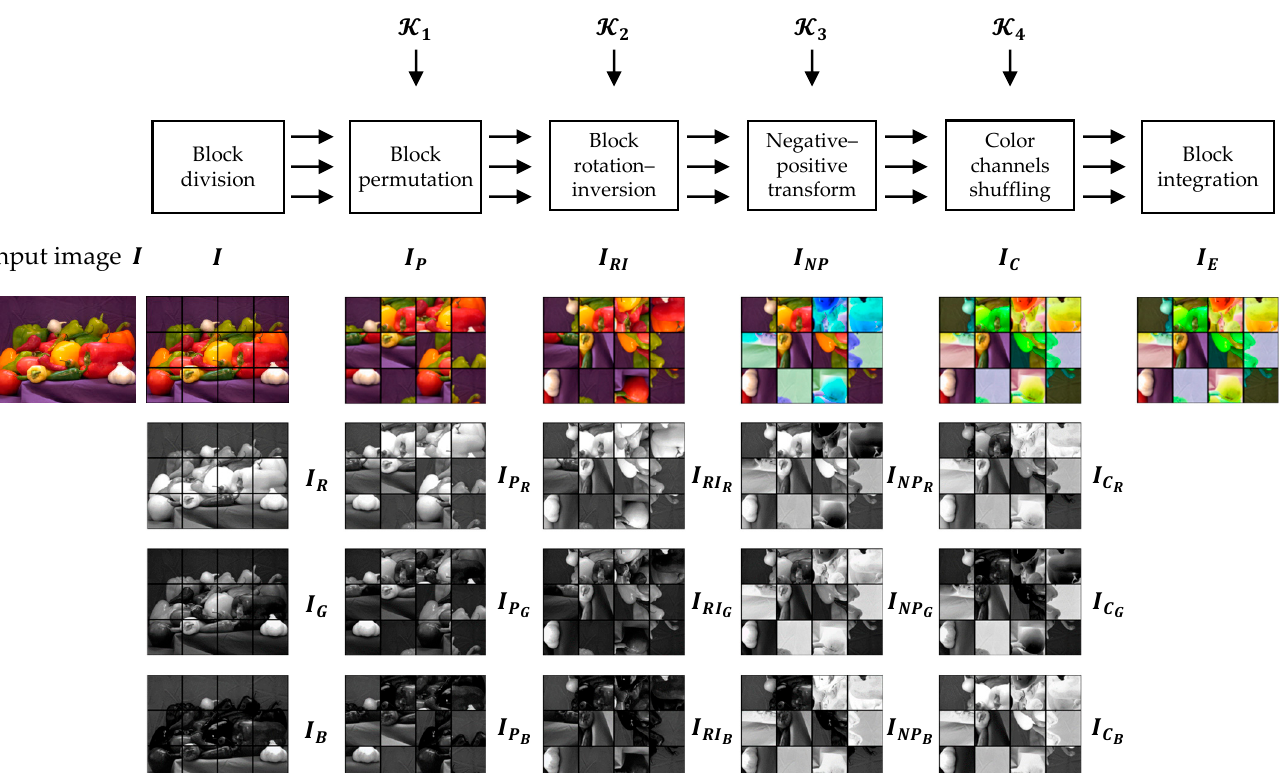
Figure 4. The encryption algorithm steps of a Color CPE scheme. For visual analysis, the effect of each transformation function on the image is shown across each color channel. The keys K i , i = 1, . . . , 4 is a set of keys used in each step to process the color channels. Because a common key is used to process each color channel, the blocks have the same appearance in each channel.